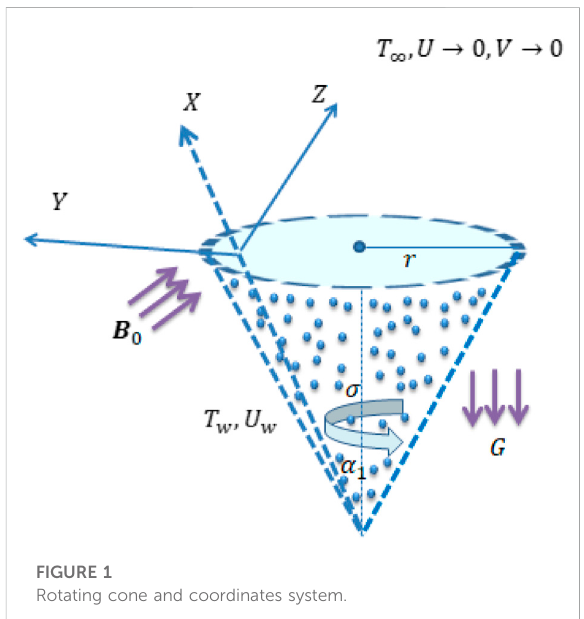
FIGURE 1 Rotating cone and coordinates